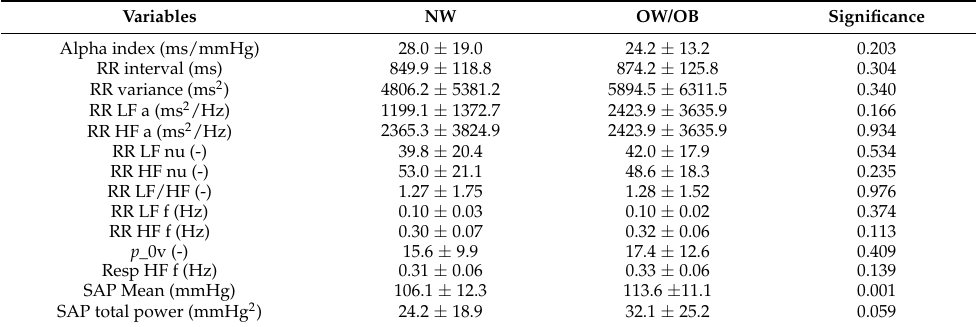
Table 2. Resting values of key autonomic indices from RR interval variability in normal weight (NW) and overweight/obese children